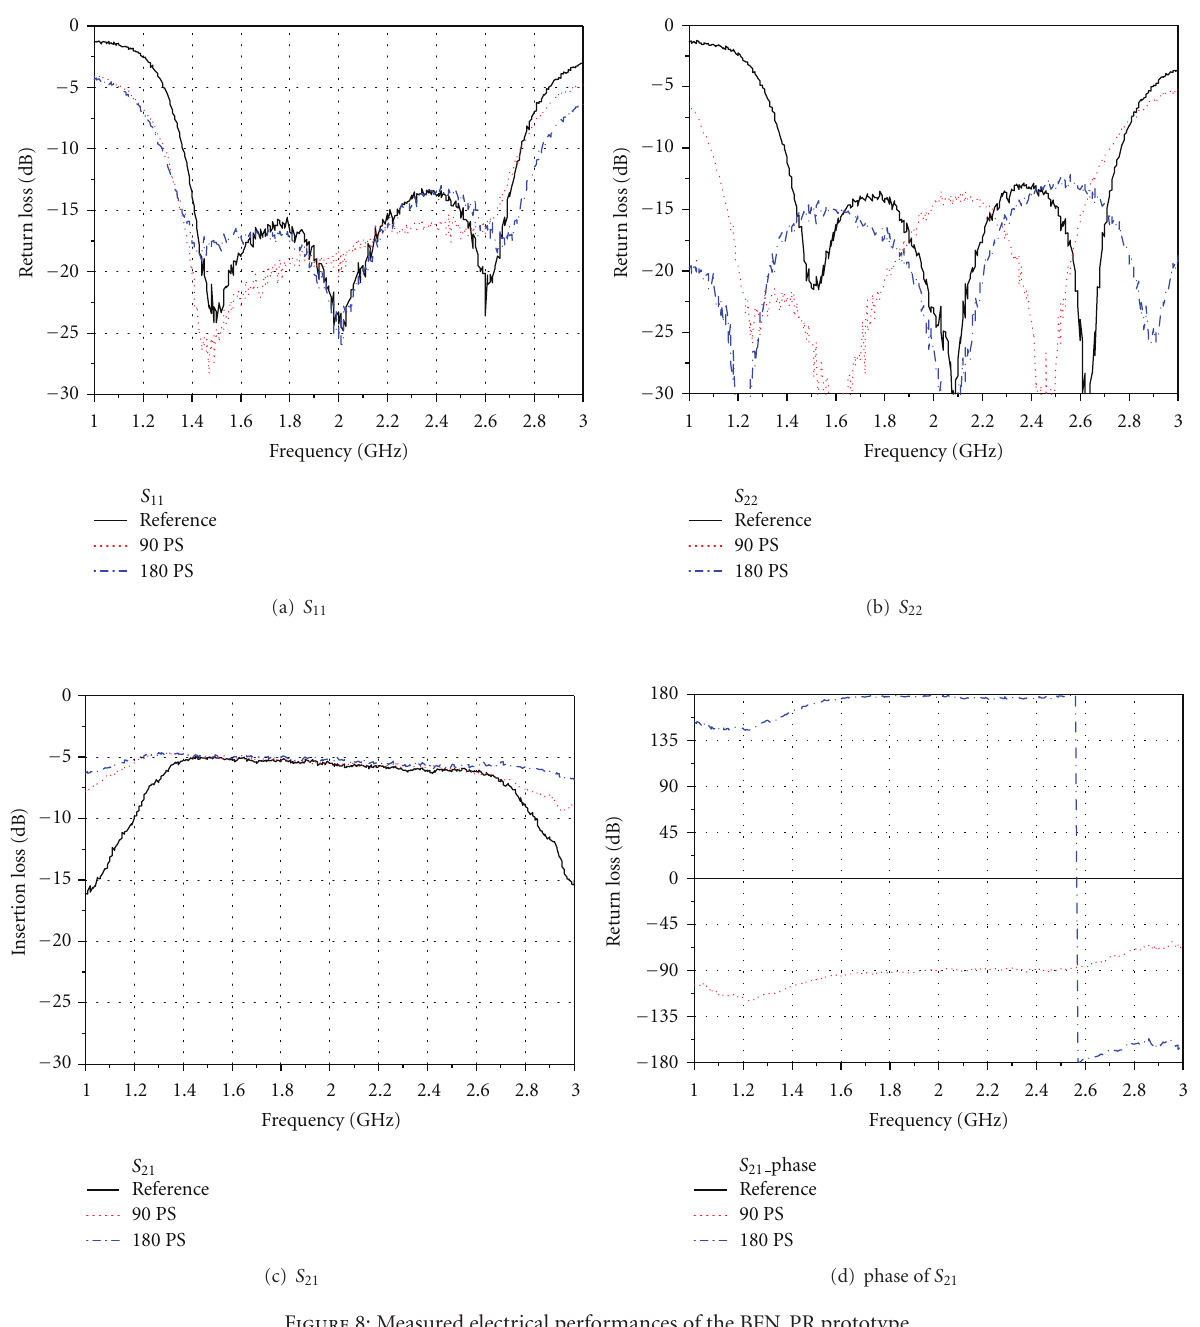
Figure 8: Measured electrical performances of the BFN PR